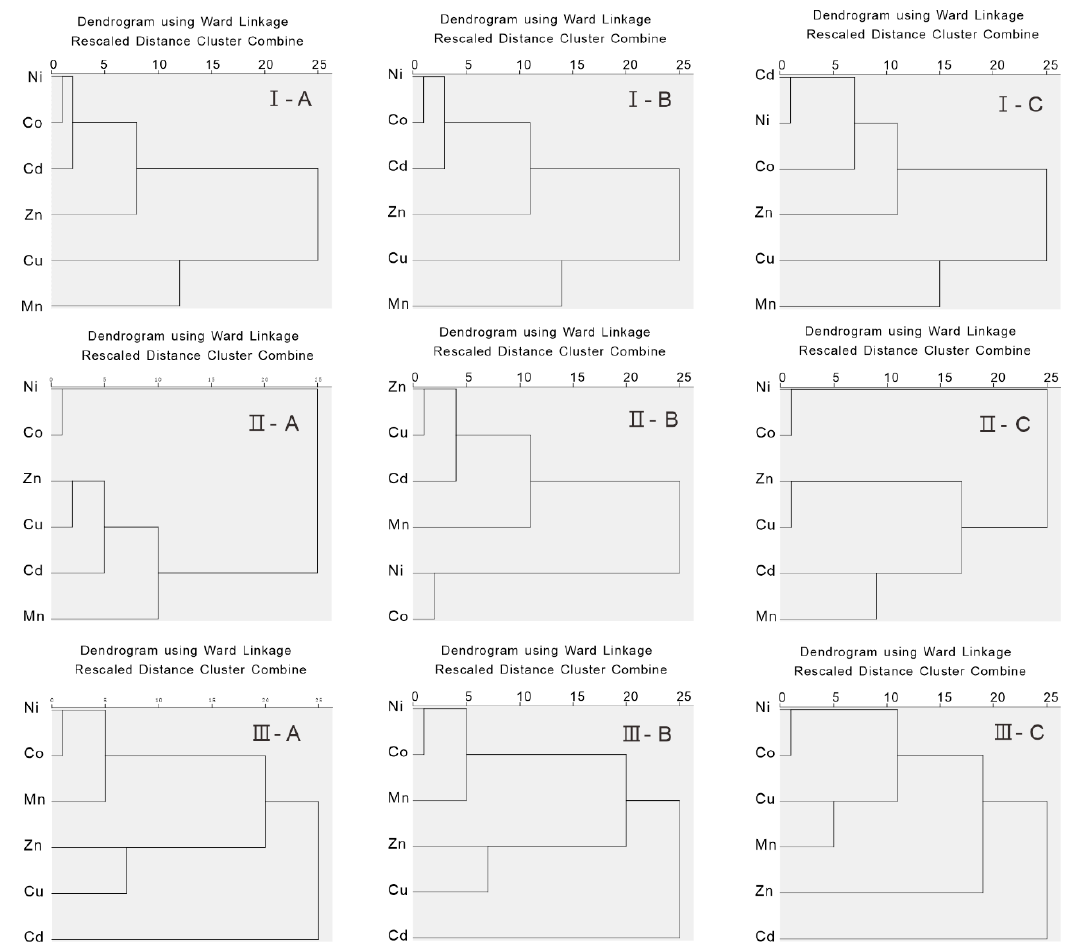
Figure 3. Of the cluster analysis data of the heavy metals in the three sampling regions (I: n = 29; II: n = 17; III: n = 29). A: The 0 − 20 cm soil layer; B: The 21 − 50 cm soil layer; and C: The 51 − 100 cm soil layer.